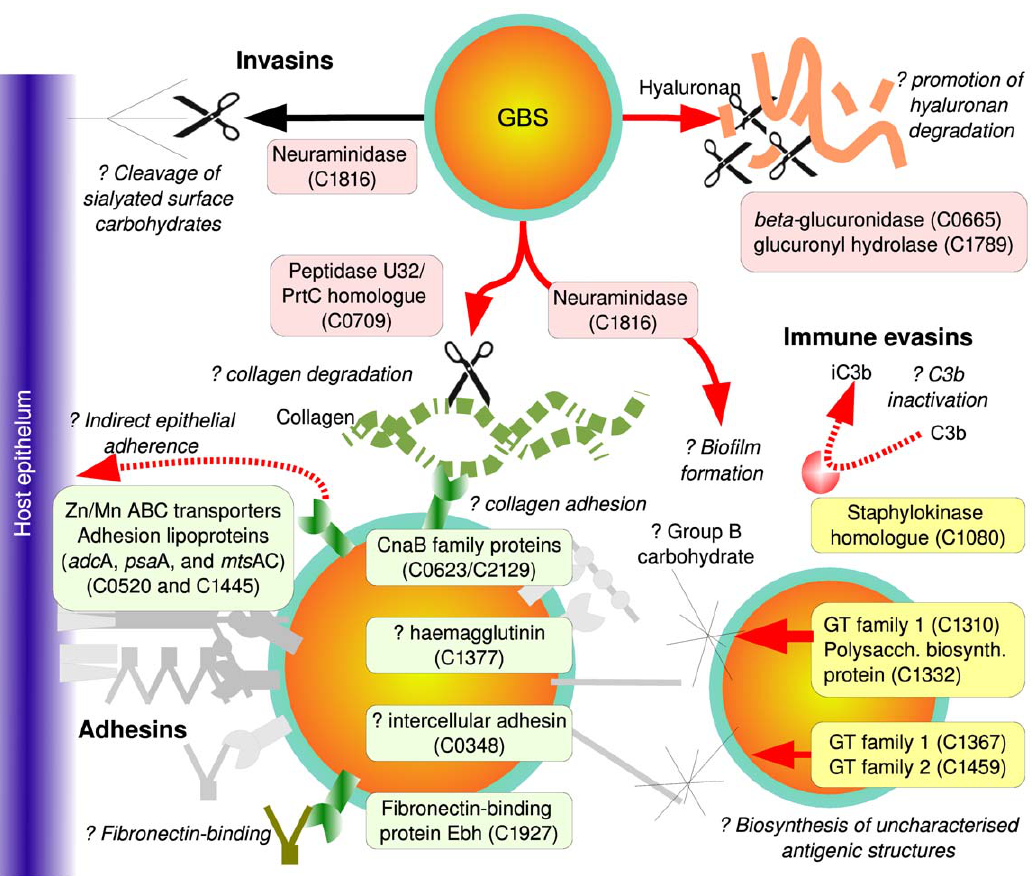
Figure 2. Proposed candidate GBS virulence genes. The figure illustrates the putative S. agalactiae virulence genes identified in this paper, of which the biological function have been known in other pathogens or inferred by sequence similarity with known protein motifs. The cluster IDs (C number ) identify the homolog clusters defined in Table S2.